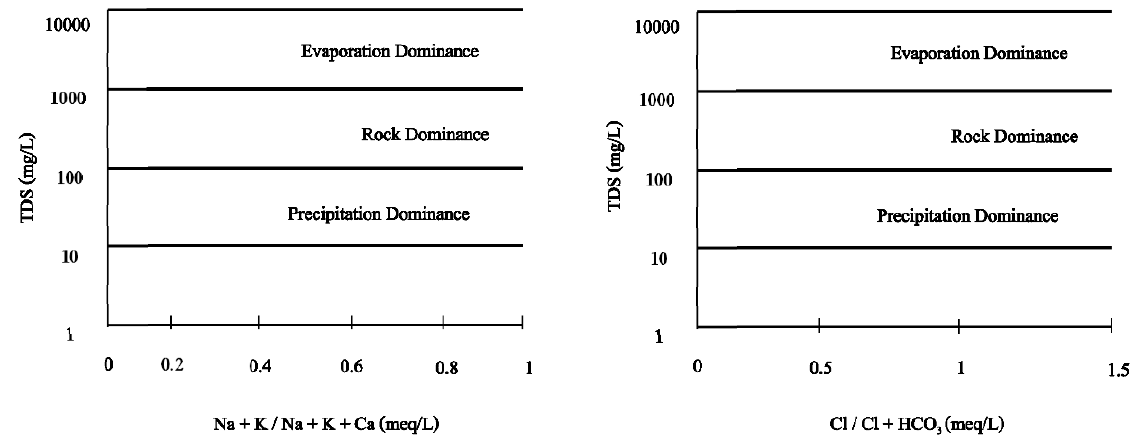
Figure 4. Gibbs Diagram for cations and anions in the study area.